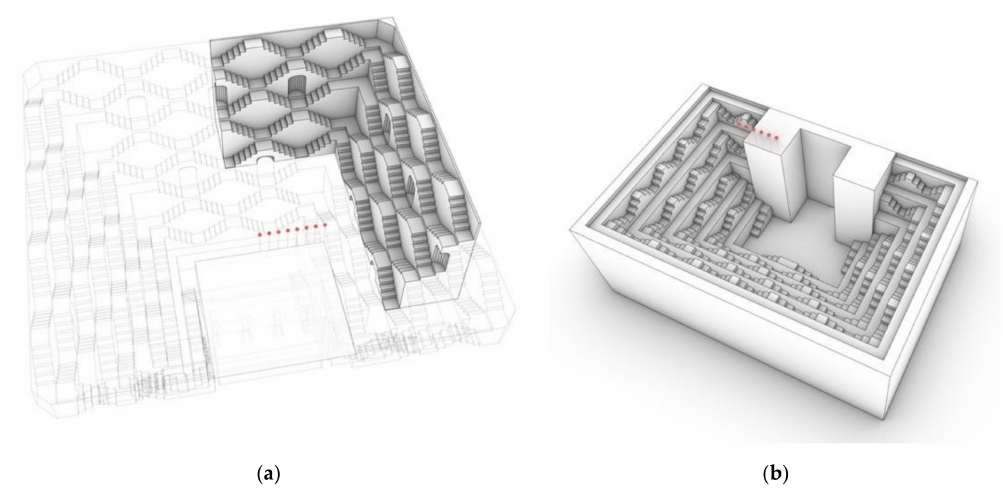
Figure 2. Perspective views of the stepwell models: ( a ) the partial model of Panna Meena ka Kund, extended with the whole stepwell lightly traced; ( b ) full model of Lahan Vav. Source positions are indicated by red dots, which are 1.5 m above the platform. Sources are numbered from the one closest to the central plane of